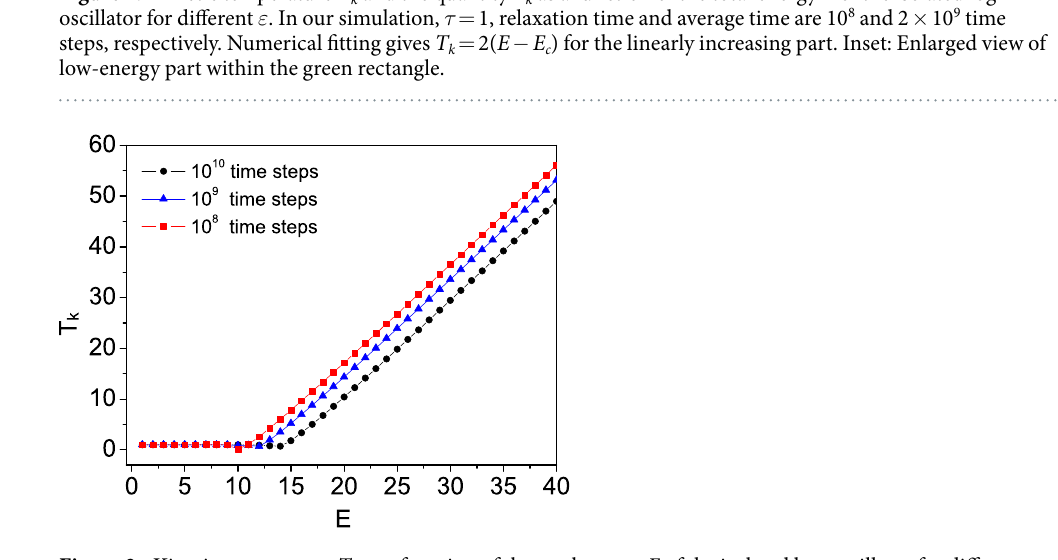
Figure 2. Kinetic temperature T k as a function of the total energy E of the isolated log-oscillator for different average time. Here τ = 1 and ε = 0.0001. The relaxation time is 10 8 time steps for all three